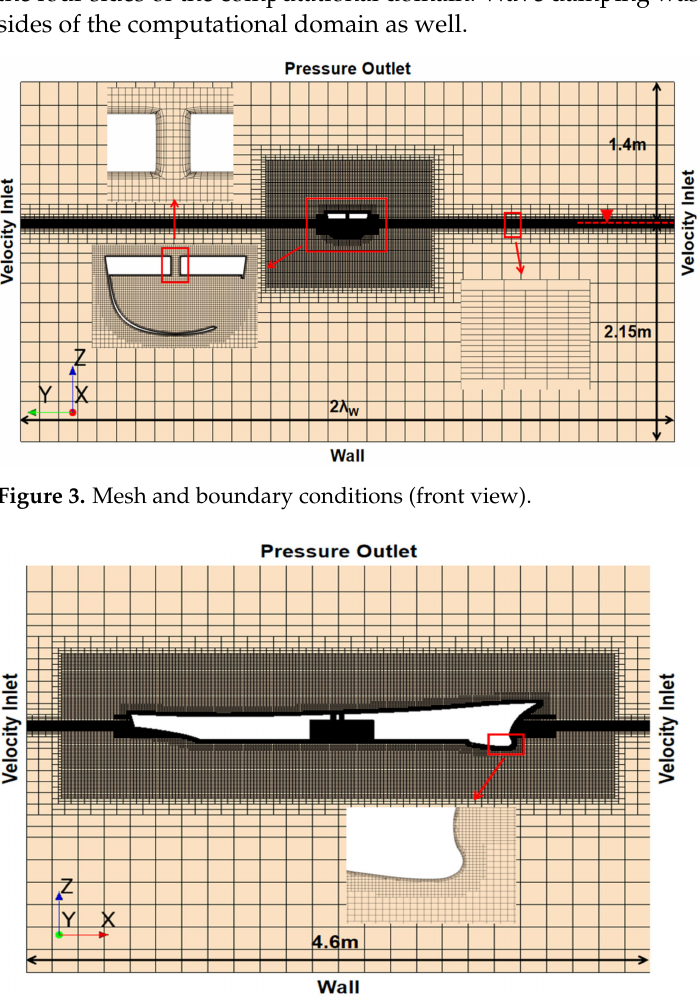
Figure 4. Mesh and boundary conditions (side